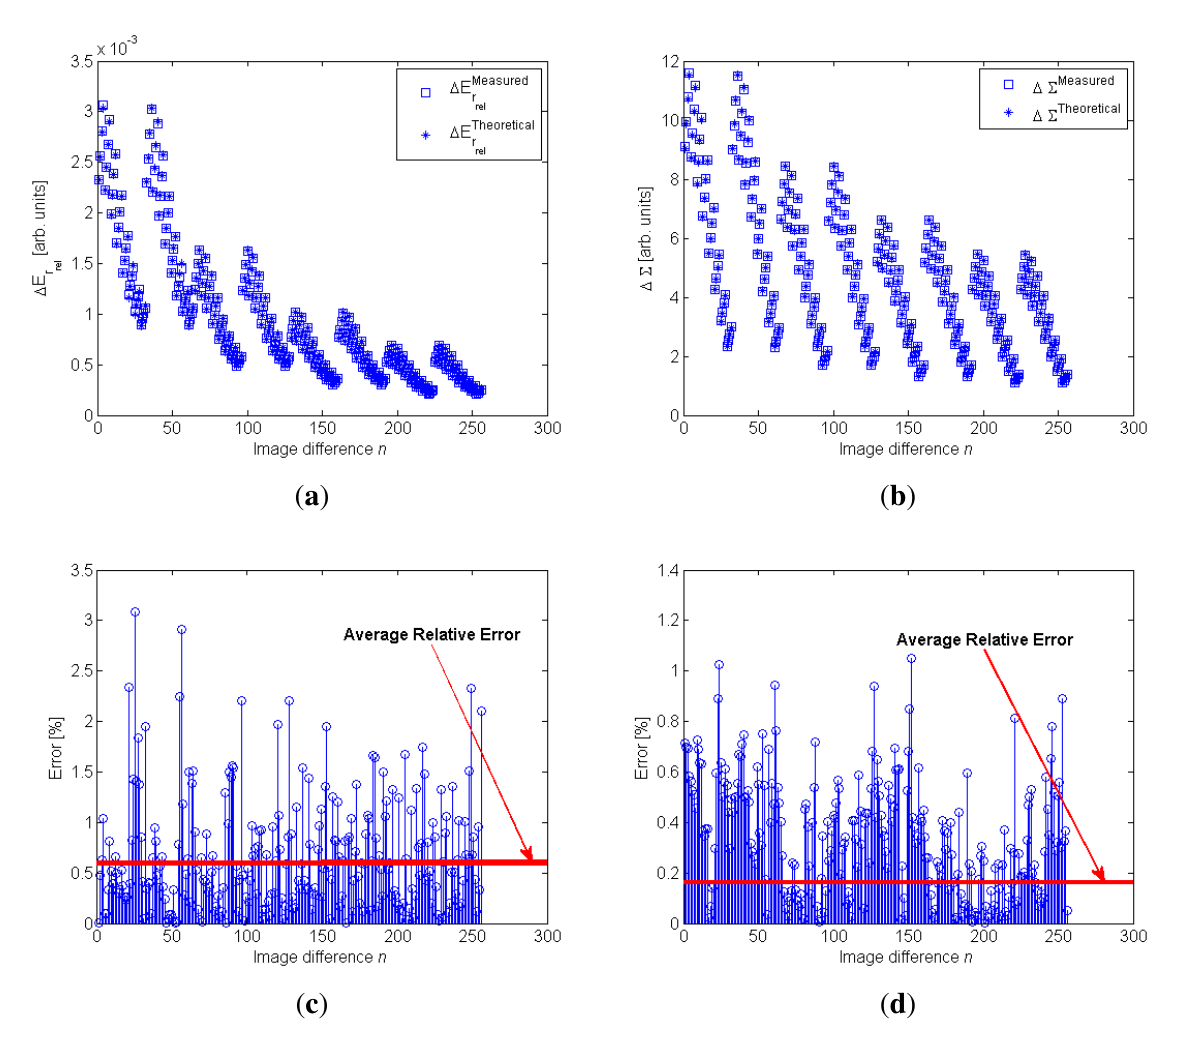
Figure 7. Results for model fitting considering the Equations (19) and (20). The fitting data x were composed of images captured with different exposure times, IRED orientation n angles, distances and IRED radiant intensities. ( a , b ) are the model fitting for the (cid:52) E model and the (cid:52) Σ model, respectively; ( c , d ) are the relative errors in [%] for model fitting for (cid:52) E and (cid:52) Σ , respectively; in addition, the average relative error is also r rel